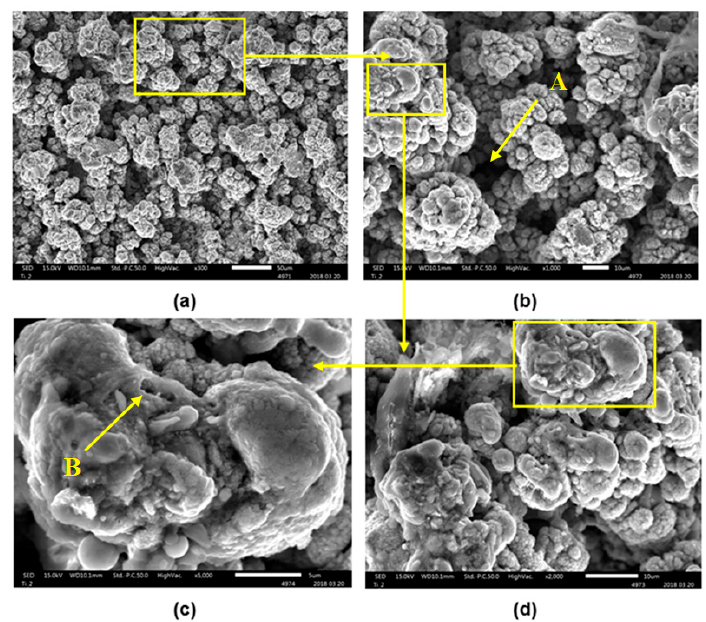
Figure 13. Multiple SEM micrographs of the machined surface B: ( a ) Original magnification of 300 × , ( b ) original magnification of 1000 × , ( c ) original magnification of 5000 × , ( d ) original magnification of 2000 × ; A—macro-sized pores, B—micro-sized pores.